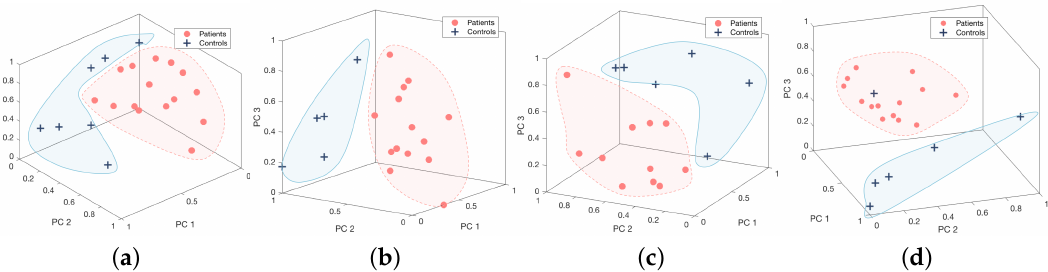
Figure 8. Principal component description of the four movement routines (( a ) pouring, ( b ) pointing, ( c ) walking, and ( d ) walking around a chair) from Sensor 2 and 3. Table 2. Optimised parameters for Sensor 2 vs. 3 combination.